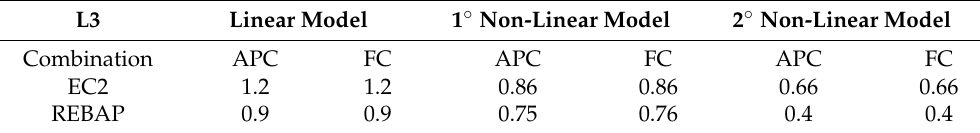
Table 10. Deformation ratios from LM, 1NLM and 2NLM for the second case of study of L3. L3 Linear Model 1 ◦ Non-Linear Model